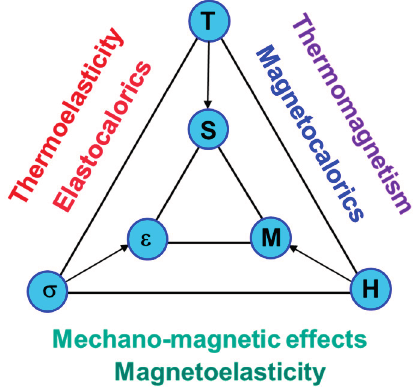
Figure 1. Scheme of the coupling between thermal, mechanical, and magnetic properties in multiferroic materials. Legend: T, temperature; S, entropy; σ , stress; ε , strain; H, magnetic field; M,